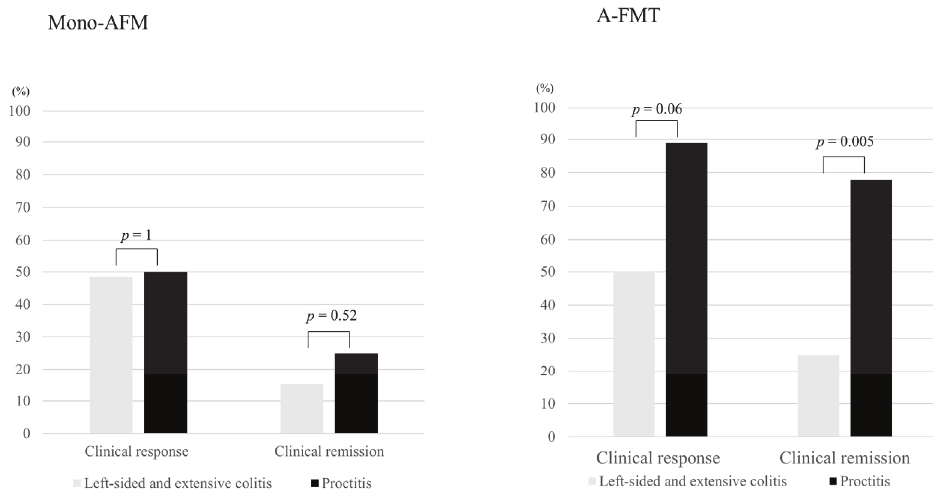
Figure 2. Comparison of the clinical response rate and remission rate by disease distribution between the mono-AFM and A-FMT groups during short-term evaluation. Although no significant difference was observed in the mono-AFM (triple antibiotic therapy (amoxicillin, fosfomycin, and metronidazole)) group, the response and remission rates were significantly higher in patients with proctitis than in those with left-sided and extensive colitis in the A-FMT (fresh fecal microbiota transplantation (FMT) following triple antibiotic therapy (amoxicillin, fosfomycin, and metronidazole)) group (left-sided and extensive colitis, n = 46; proctitis, n = 9; clinical response, p = 0.06; clinical remission, p = 0.005, chi-square test).